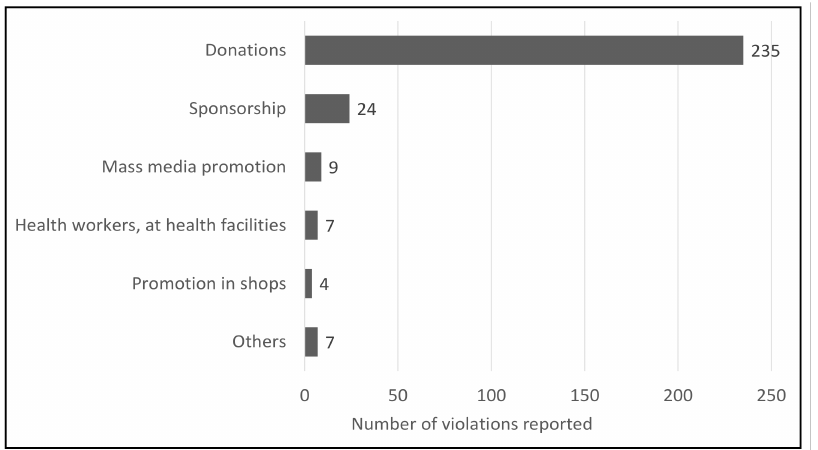
Figure 13. Percentage of reported violations in the Philippines since the pandemic